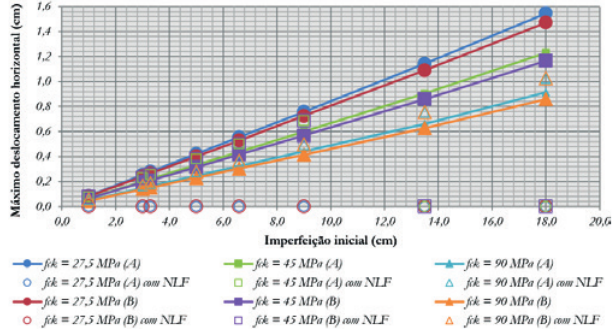
Figura 12 Máximos deslocamentos horizontais com análise não linear